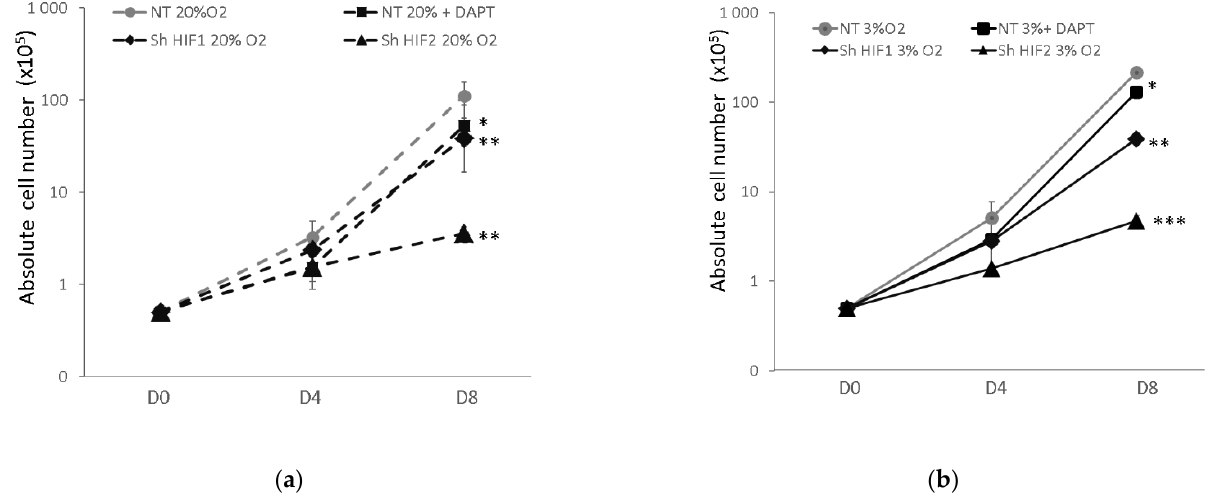
Figure 2. Erythroid cell expansion Non-transduced CD34 + cells in presence ( ◼ ) or absence ( ⚫ ) of Notch γ -secretase inhibitor DAPT as well as transduced CD34 + cells with shHIF1α ( ⯁ ) or with shHIF2α ( ▲ ) were grown in erythroid medium for 8 days at 20% (dashed line, ( a )) and at 3% O 2 (solid line ( b )). Data represent the absolute number of cells obtained from 50 × 10 3 CD34 + cell at Day 0. The values are expressed as the mean ± SD of seven independent experiments at the logarithmic scale. Asterisks indicate a significant difference with respect to NT condition, at p < 0.05 (*), p < 0.01 (**), p < 0.001 (***), Mann – Whitney test. NT, non-transduced CD34 + cells; D, day of culture .